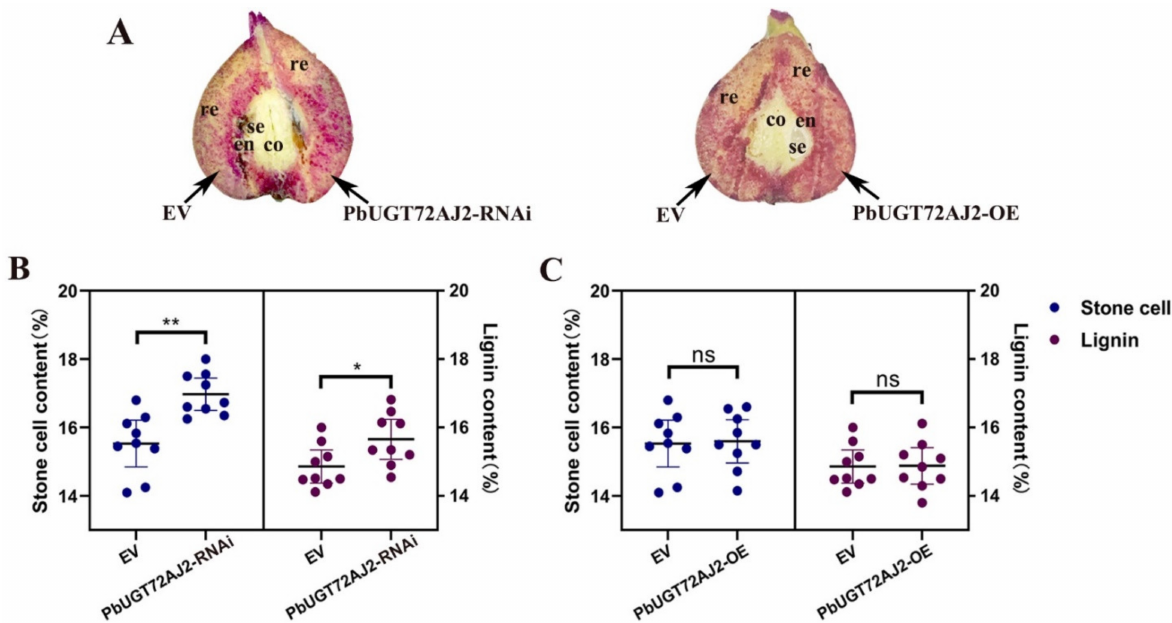
Figure 6. Transient assays using PbUGT72AJ2 silencing and overexpression constructs in ‘Dang- shansuli’ fruit at 39 days after flowering (DAF). Images were taken 10 days after agro-infiltration. ( A ) cross-sections of the pear fruits were stained with phloroglucinol–HCl. re, receptacle; en, endo- carp; se, seed; co, core. ( B , C ) Lignin and stone cell contents in the flesh tissue around the infiltration sites, more than three fruits were injected with each construct in an experiment that was repeated three times. EV: empty vector; (* p < 0.05, ** p < 0.01; ns, no